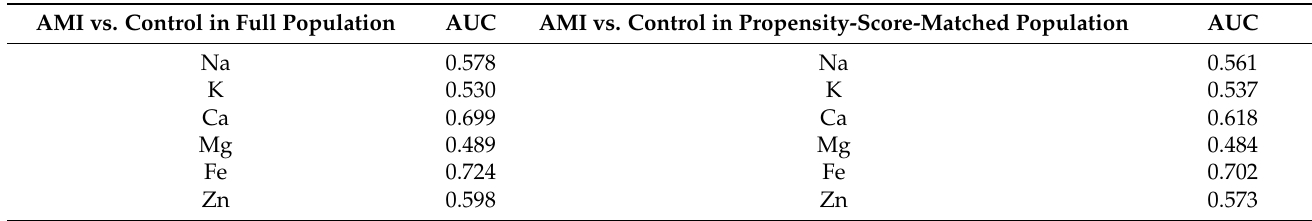
Figure 3. The ROC curve of the AMI vs. the SCAD. ( a ) The ROC curve before propensity score- matching. ( b ) The ROC curve after propensity score-matching. The area under the curve of the var- ious trace elements is summarized in Table 8. Table 7. The ROC curve of the AMI vs. the SCAD group.